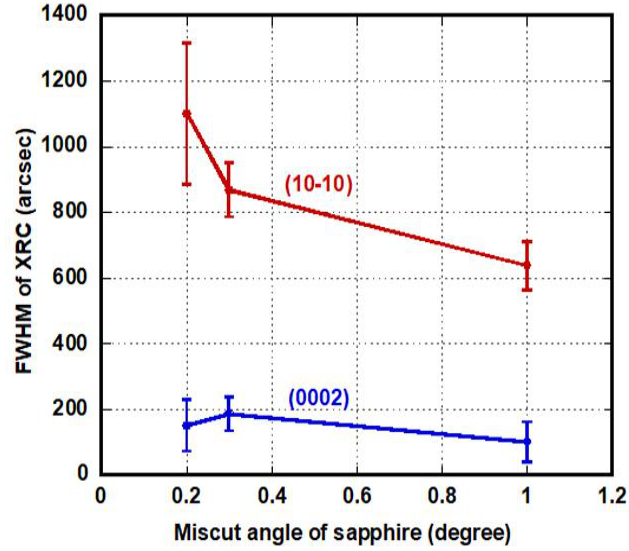
Figure 9. Results of AlN template grown on sapphires with miscut angles of 0.2°, 0.3°, and 1.0°. The numbers of samples with 0.2°-, 0.3°-, and 1.0°-miscut sapphire were 25, 20, and 43, respectively. The FWHMs of ω-scans of the (0002) and (10-10) XRCs were 101 ± σ61 and 638 ± σ74 arcsec, respectively, for the sapphire with a miscut angle of 1.0°. The thickness of AN was slightly greater than 2 µm and the growth rate was set to about 1 µm/h. (Permitted to be reproduced from Jpn. J. Appl. Phys. [13]. © Japan Society Applied Physics).